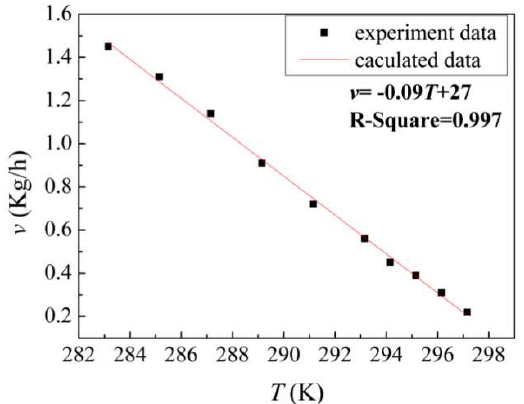
Figure 3. Crystallization rate v controlled by changing the temperature T of the cooling water, between 283.15 K and 297.15 K. The black points represent experimental measurements, and the red line is obtained by linear fitting.